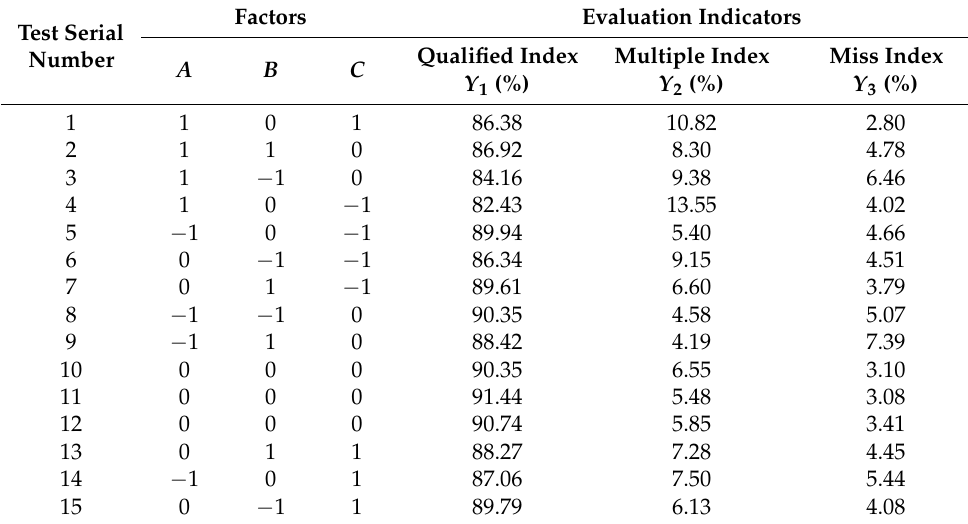
Table 3. Experimental design and results.